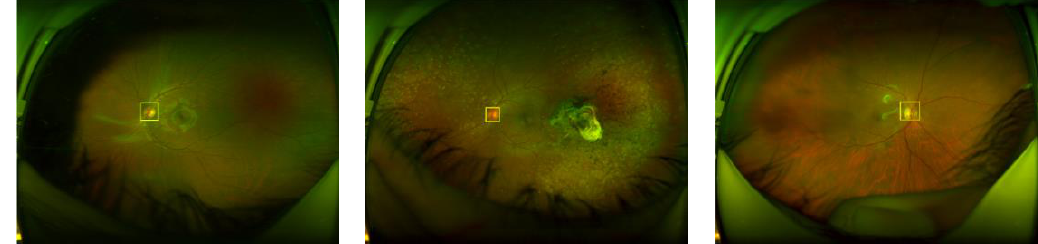
Figure 4. Examples of manual bounding-box labeling of the OD.